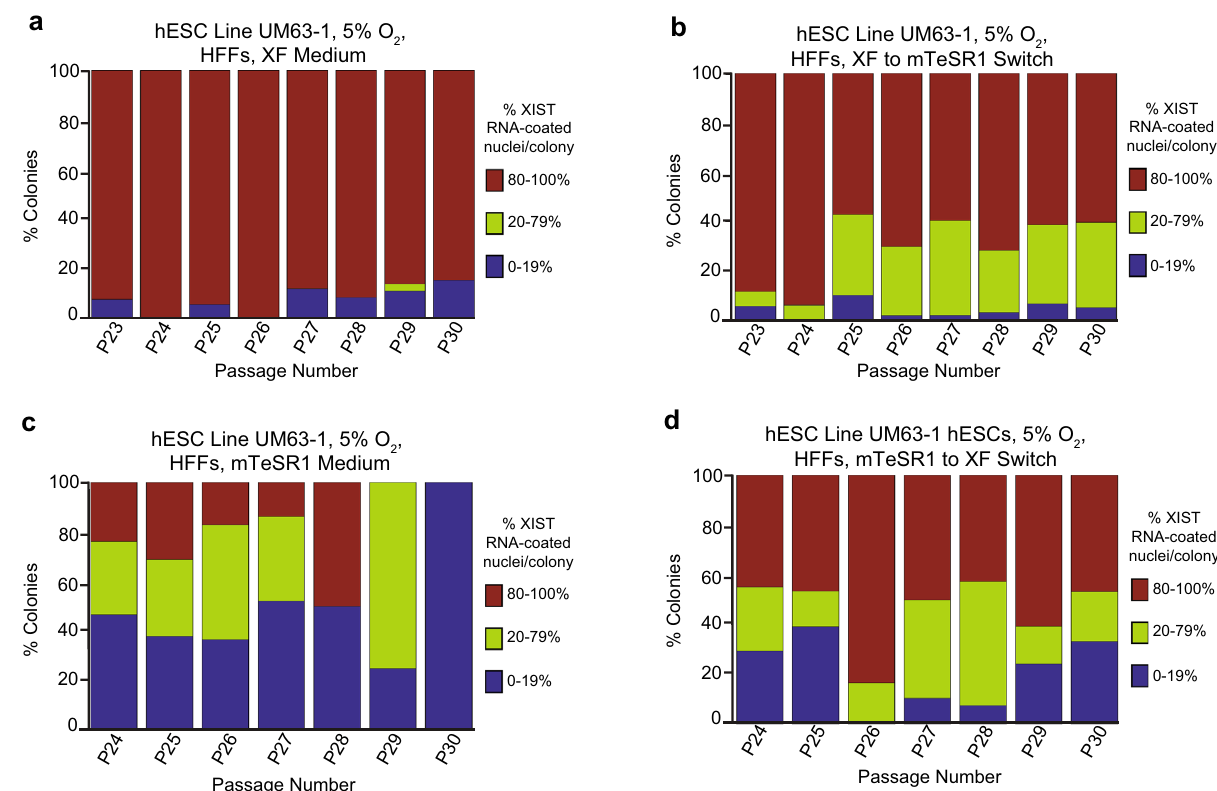
Fig. 5 Analysis of culture media switching on XIST RNA coating in female hESCs. Percentage of nuclei with XIST RNA coats per colony of hESC line UM63-1 ( a ) cultured continuously in XF medium and ( b ) cultured initially in XF medium and subsequently switched to mTeSR1 medium. Percentage of nuclei with XIST RNA coats per colony of hESC line UM63-1 ( c ) continuously cultured in mTeSR1 medium and ( d ) cultured initially in mTeSR1 medium and then switched to XF medium. hESCs cultured initially in XF medium and subsequently switched to mTeSR1 medium displayed a signi fi cant decrease in nuclei with XIST RNA coating during passaging compared to hESCs cultured continuously in XF medium (general linear model comparison, p = 0.01). hESCs cultured continuously in mTeSR1 medium displayed a signi fi cant decrease in nuclei with XIST RNA coating during passaging compared to hESCs cultured initially in mTeSR1 medium and then switched to XF medium (general linear model comparison, p < 0.001). All hESCs in this experiment were cultured in 5% O 2 on HFFs. See also Supplementary Fig. 3 and Supplementary Fig. 4. At least 100 nuclei were counted per colony for hESC RNA FISH quanti fi cation. The total number of colonies quanti fi ed at each passage range between 2 and 148 and are cataloged in source data. Source data are provided as a Source Data fi